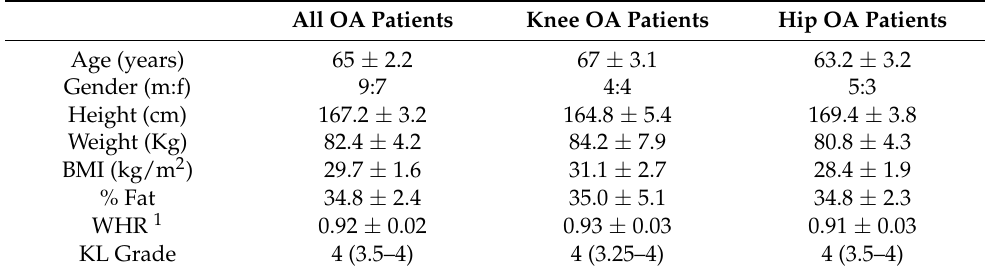
Table 1. OA patient